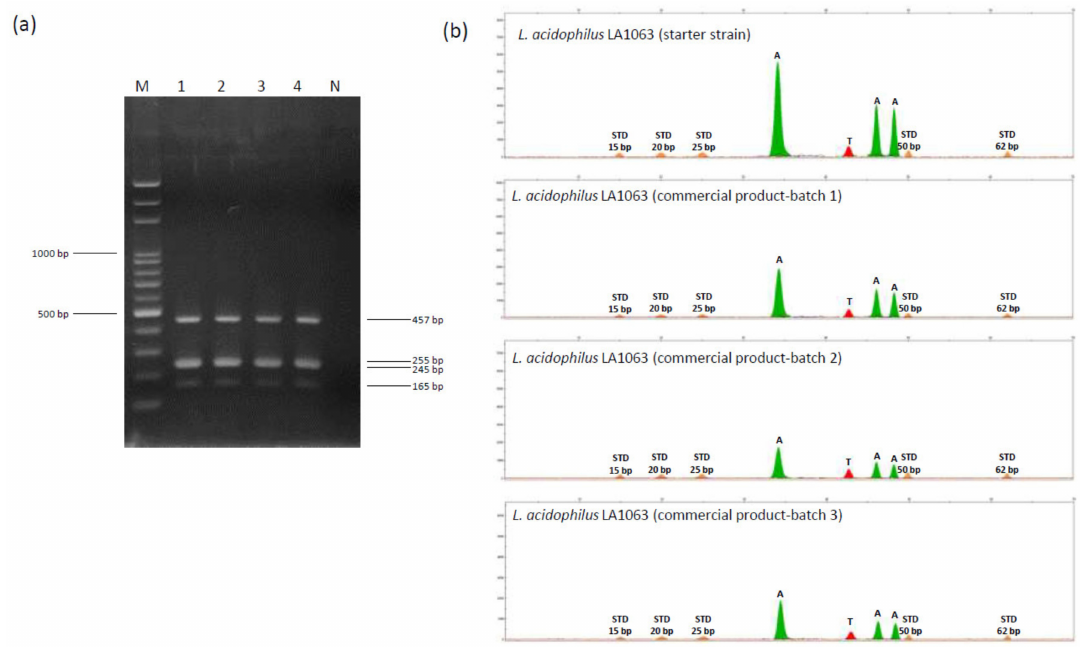
Figure 5. Single nucleotide polymorphism (SNP) genotyping of four polymorphisms in the phoU , secY , tilS , and uvrA_ 1 distinguished genes on the Lactobacillus acidophilus LA1063 strain. ( a ) Electropherogram of a 2% agarose gel containing multiple PCR products derived from four DNA fragments. Lane M, 100-bp ladder DNA marker; lane 1, LA1063 probiotic strain; lanes 2-4, LA1063 isolated from separate batches of its derived probiotic product; and lane N, negative control. ( b ) Electropherograms obtained from the LA1063 strains by four-plex SNaPshot minisequencing assay. The X -axis represents the size of the minisequencing products (nucleotides); the Y -axis represents relative fluorescence units (RFUs). STD: GS120 LIZ size